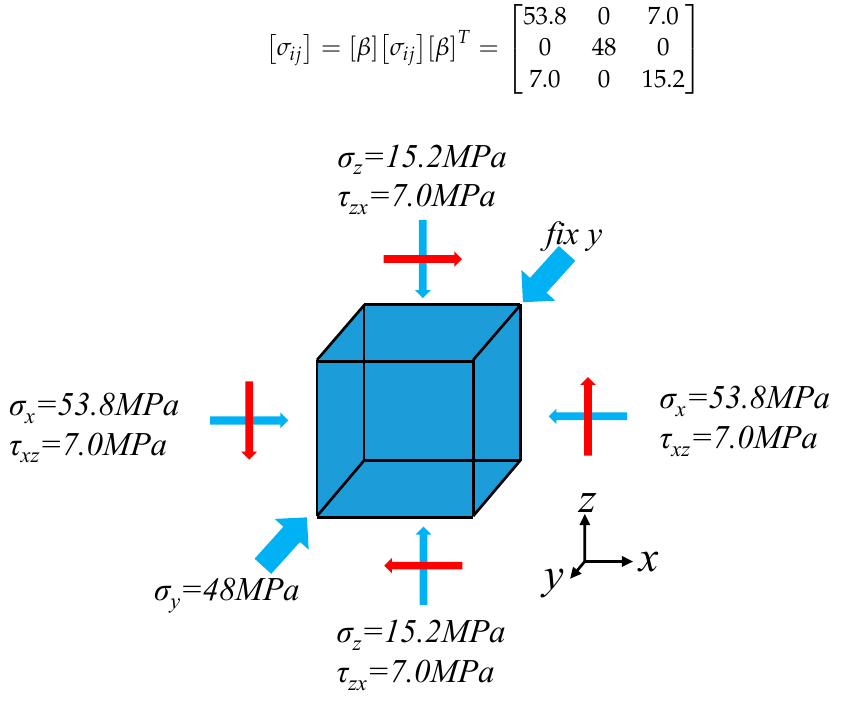
Figure 4. Boundary conditions of the numerical model.